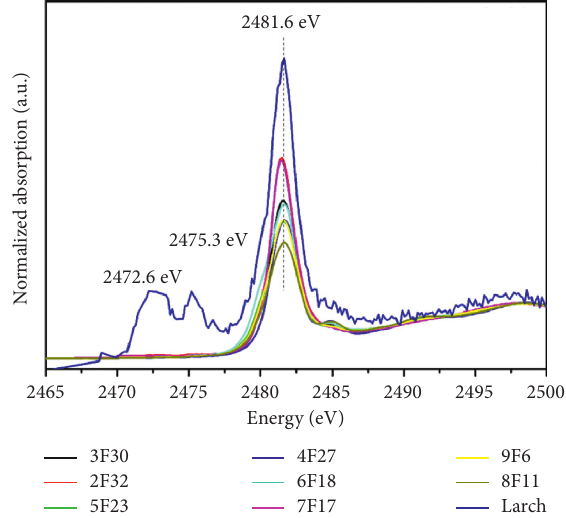
Figure 5: XANES spectra of the aged and sound samples. The dominant peak is sulphate (2481.6eV), and the two additional peaks at 2472.6 and 2475.3eV in the sound sample spectrum can be attributed to the reduced forms of sulphur such as aliphatic sul- phide and